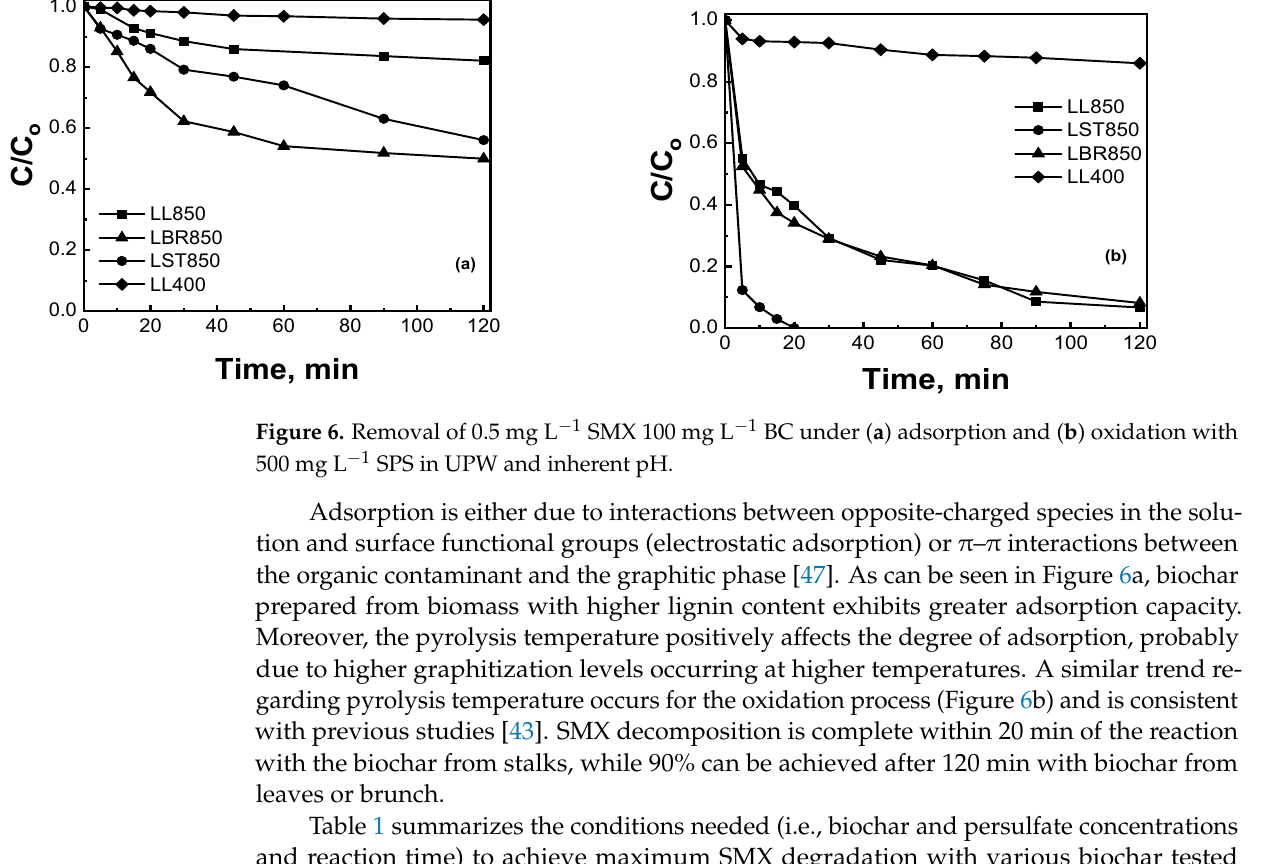
Table 1. Removal of SMX with biochar from different biomasses pyrolyzed at 850 ◦ C. Values with asterisks refer to an experiment with trimethoprim as the target